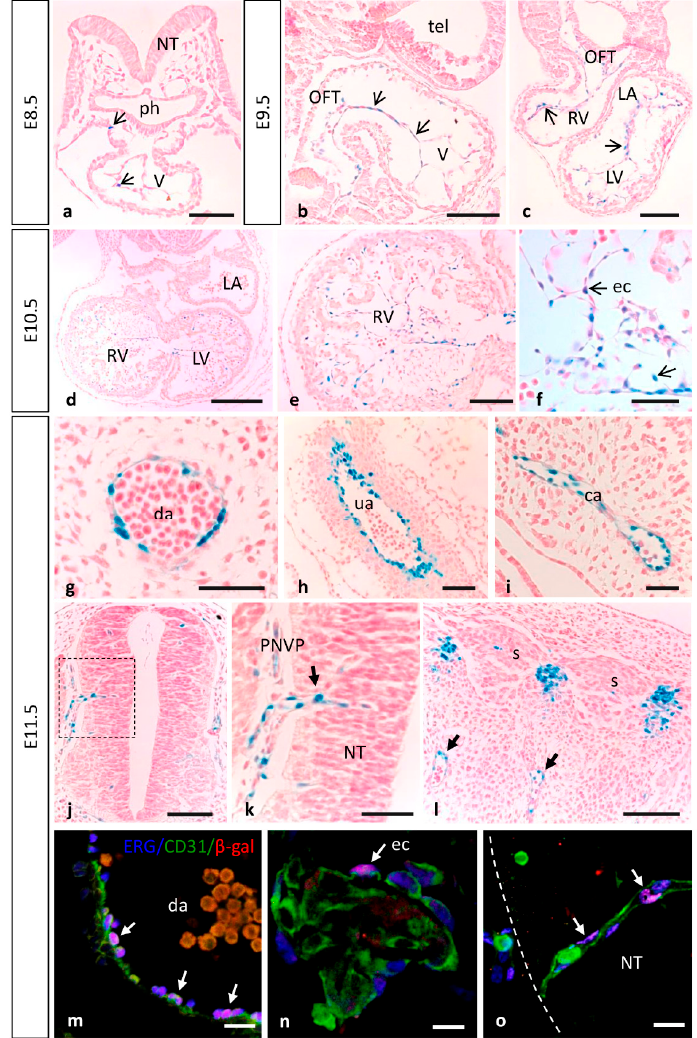
Figure 2. MT1-MMP is expressed at early embryonic stages in the developing cardiovascular system. ( a – f ) β -gal staining of paraffin sections from E8.5 to E10.5 Mt1-mmp LacZ/+ embryos re- vealed expression of MT1-MMP in the endocardial tissue lining the primitive heart tube at early embryonic stages (arrows in ( a )), and the endocardium of the atrium, the ventricle and the cardiac outflow tract at E9.5 (arrows in ( b ), sagittal section; arrows in ( c ), coronal section) and at E10.5 ( d – f ). ( g – l ) Mt1-mmp LacZ/+ expression was detected in large blood vessels such as the dorsal aorta ( g ), the umbilical artery ( h ) and the carotid artery ( i ) of E11.5 embryos. At this embryonic stage, β -gal positive cells were detected in the perineural vascular plexus that surrounds the neural tube ( j , k ) and in somites ( l ), in a pattern compatible with intersomitic arteries (arrows in ( l )). Note the β -gal labeling in endothelial cells of a blood vessel sprouting into the neural tube (arrow in ( k )). ( m – o ) Confocal images of immunohistochemistry for the endothelial transcription factor ERG (blue), the membrane marker for endothelial cells CD31 (green) and the reporter β -gal (red), demonstrate MT1-MMP ex- pression in endothelial cells of the dorsal aorta ( m ) and the endocardial endothelium of the primitive heart tube ( n ) of E11.5 embryos. MT1-MMP expression was also demonstrated in the endothelial cells from the first blood vessels entering the brain parenchyma ( o ). See images from split channels in Figure S1. Abbreviations: ca, carotid artery; da, dorsal aorta; ec, endothelial cell; OFT, outflow tract; LA, left atrium; LV, left ventricle; NT, neural tube; ph, pharyngeal region; PNVP, perineural vascular plexus; RV, right ventricle; s, somite; tel, telencephalon; V, ventricle; ua, umbilical artery. Scale bars: 250 µ m ( d ), 100 µ m ( a – c , e , j , l ), 50 µ m ( f , g , k , m – o ), 20 µ m ( h , i